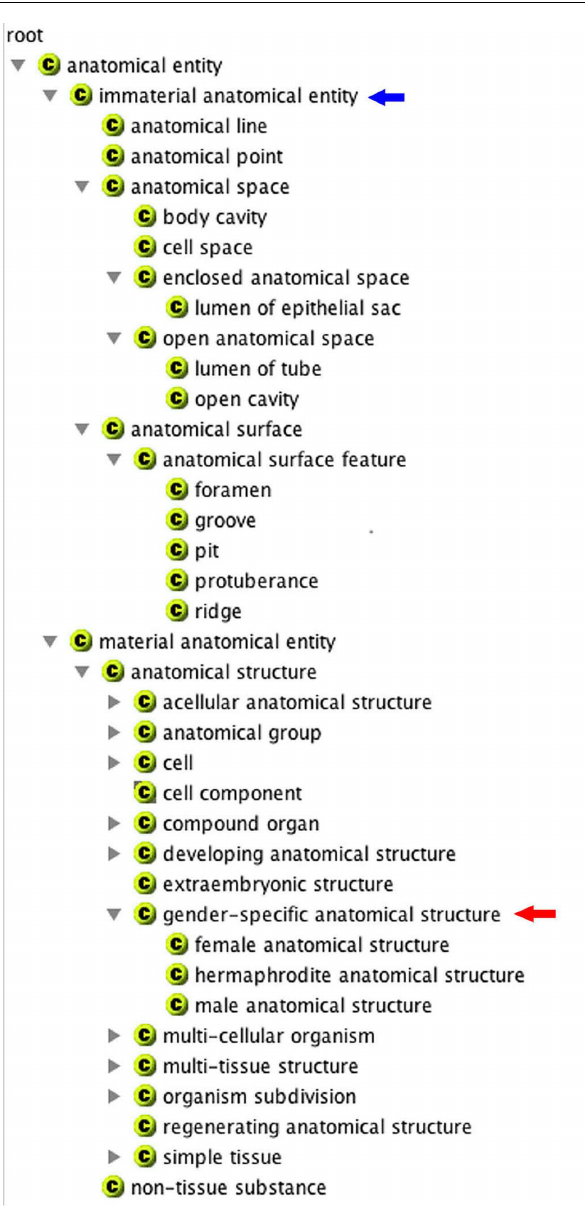
FIGURE 1 |TheAEO shown in the COBrA browser. Here, the hierarchies for immaterial anatomical entities (blue arrow) and gender-specific anatomical entities (red arrow) are expanded.